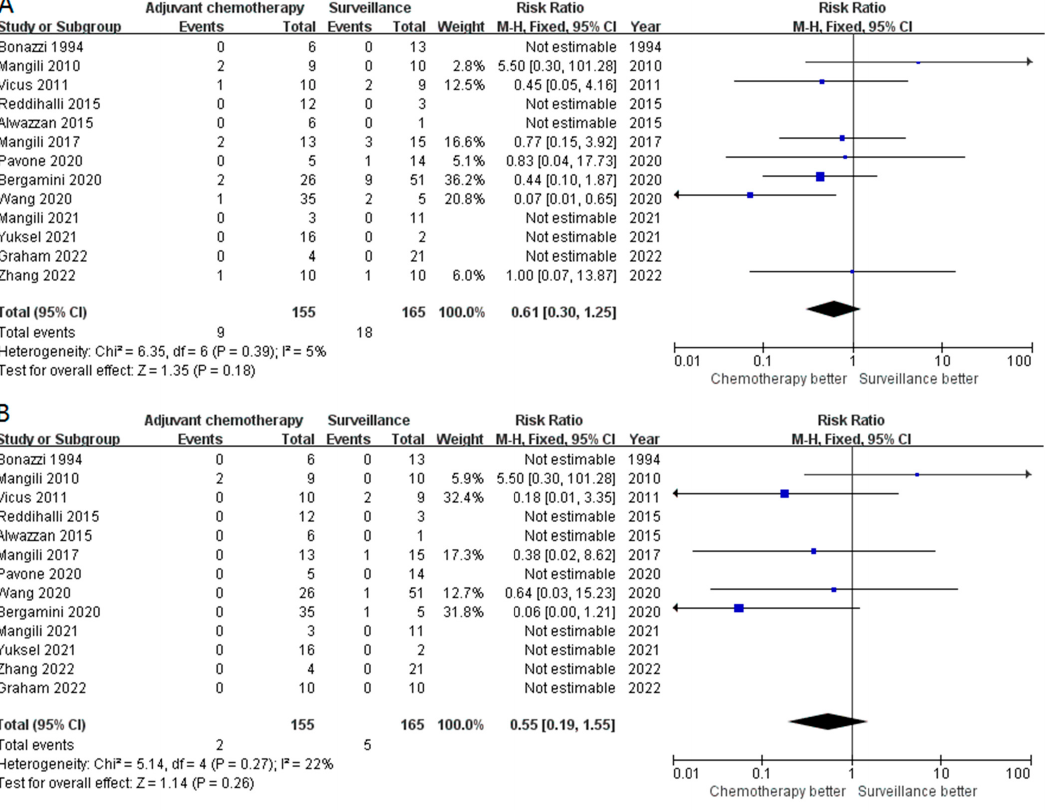
Figure 4. The risk of recurrence ( A ) and mortality ( B ) did not differ between patients with stage I G2-G3 POIT who underwent adjuvant chemotherapy and surveillance.